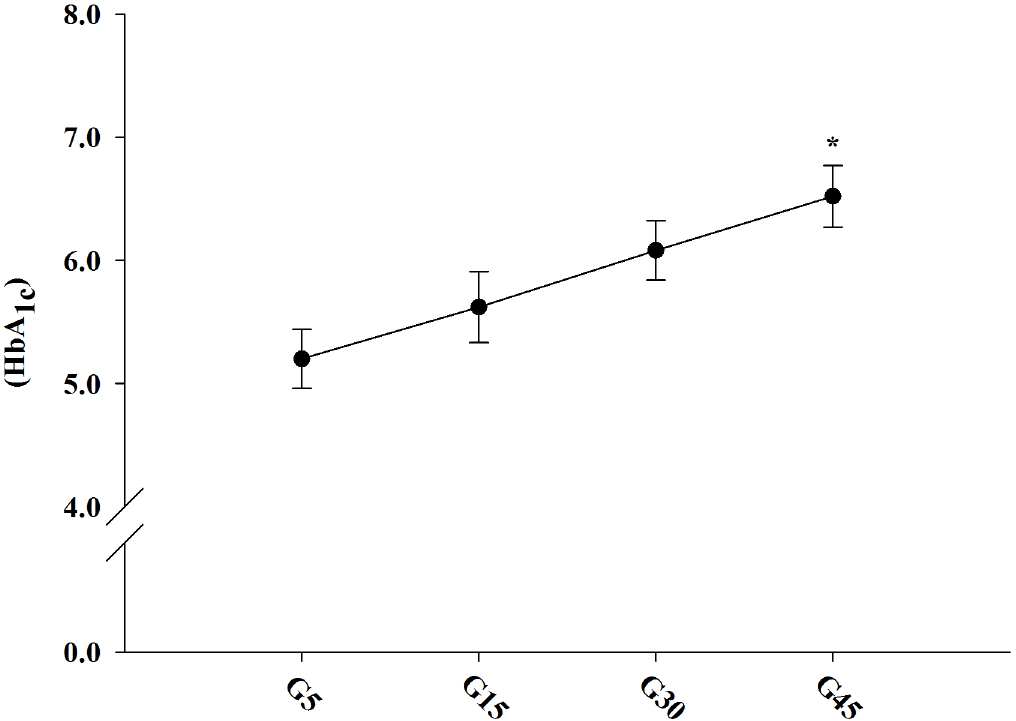
Fig 1. The concentration-dependent effects of 5 – 45 mM glucose on protein glycation (glycated hemoglobin or HbA 1c ) in erythrocytes at 37°C for 24 h. The results were expressed as mean ± SEM ( n = 6). * p < 0.05 when compared to 5 mM glucose (G5) treatment.